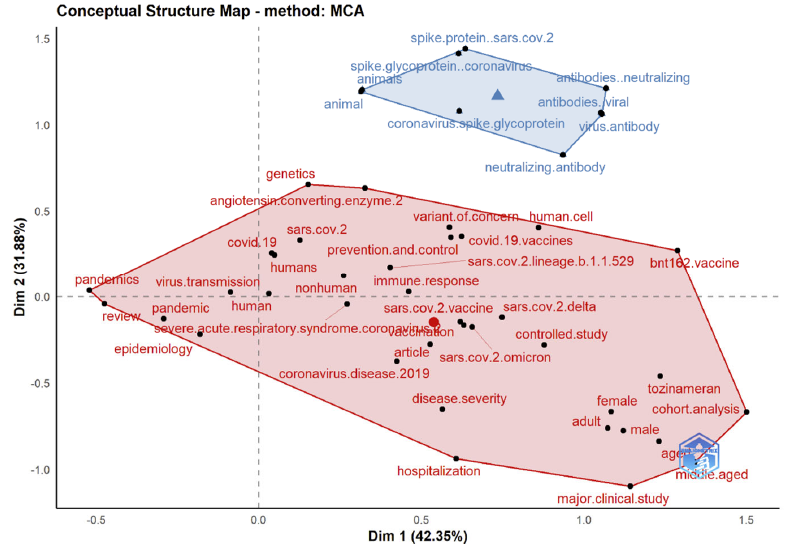
Figure 17. Conceptual structure map (multiple correspondence analysis).